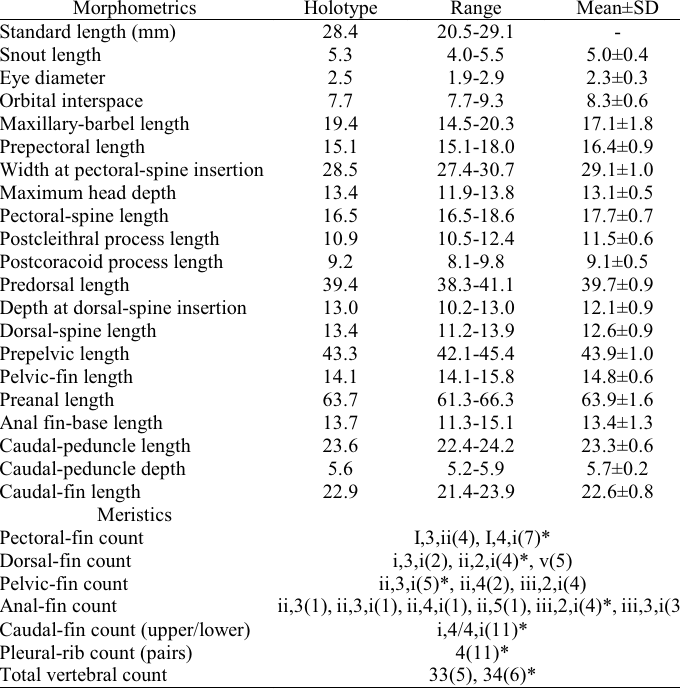
Table 1. Summary of morphometric measurements and meristic counts for Pseudobunocephalus lundbergi (N=11; Holotype, ANSP 168817, and 10 syntopic Paratypes, ANSP 172504). Standard length expressed in mm. All other measurements expressed in percent of SL. Meristic data for holotype is identified by a *